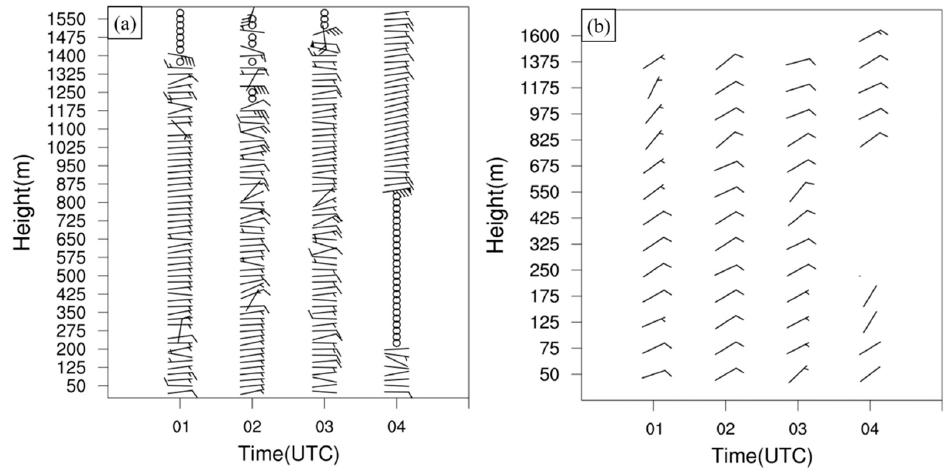
Figure 2. Comparisons between wind observations of ( a ) the initial profile and ( b ) thinning profile at Pingtung Airport from 0100 to 0400 UTC (0900 to 1200 LST) on 5 August 2018. Abnormal winds are represented by black circles in ( a ).